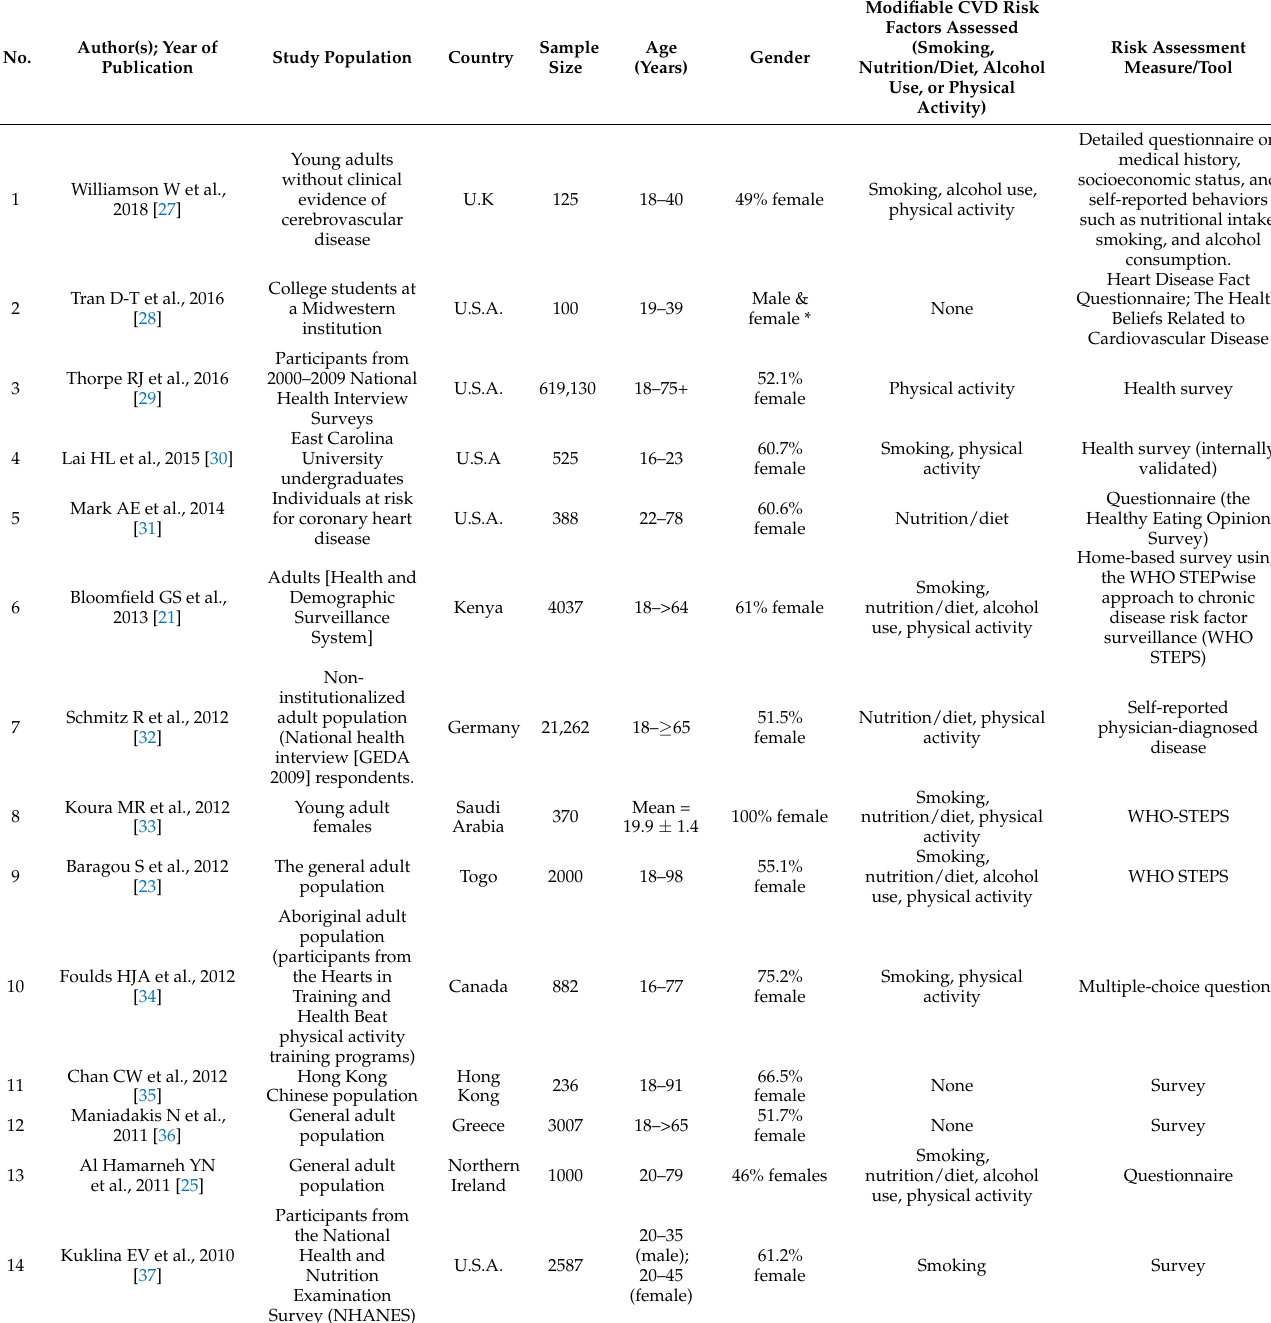
Table 3. Summary of included studies that used non-clinical tools for risk assessment in the general young adult